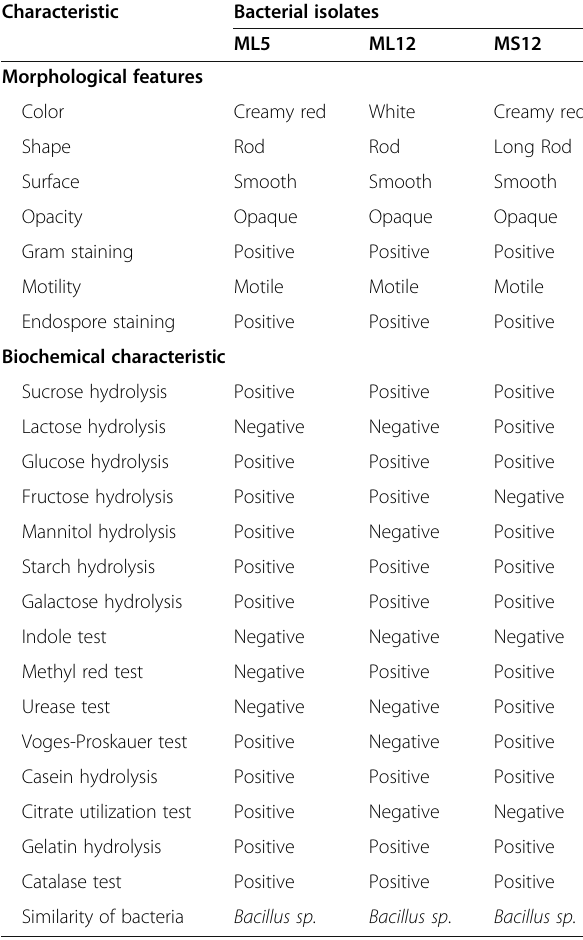
Table 3 Morphological and biochemical characterization